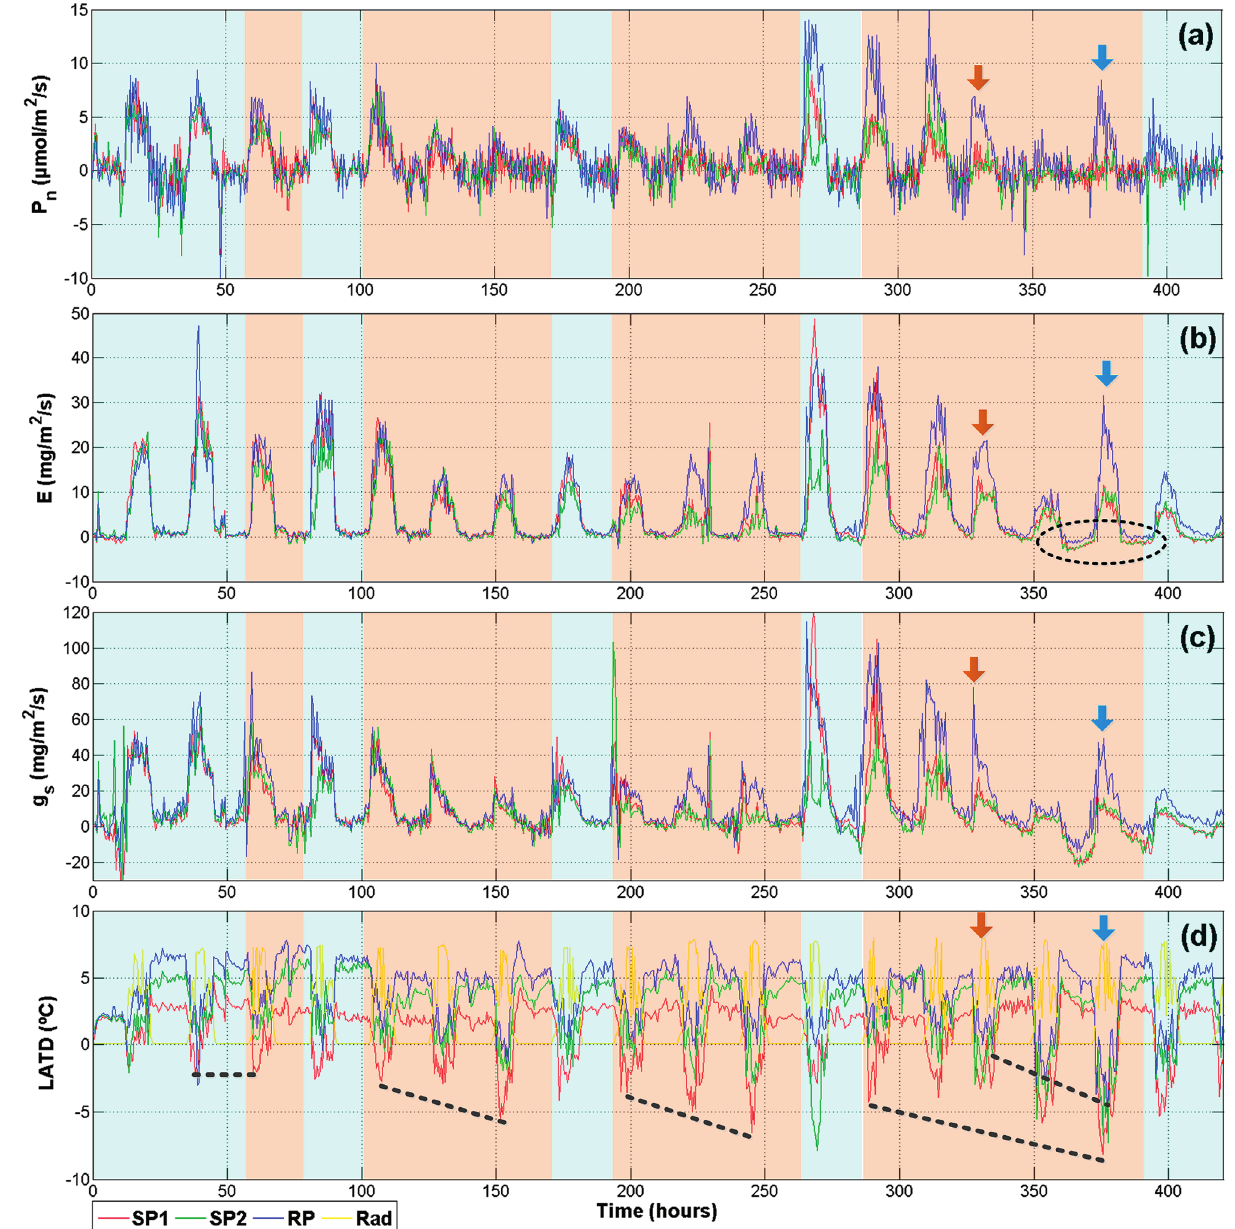
Figure 9. Physiological signals. ( a ) Photosynthesis; ( b ) transpiration; ( c ) stomatal conductance; and ( d ) leaf to air temperature